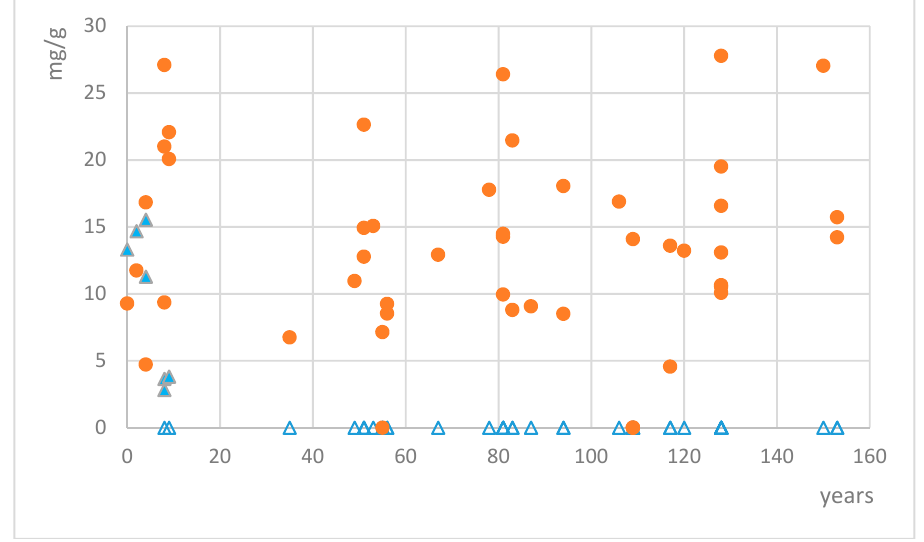
Figure 3. Concentrations of mycosporine glutamicol (red circles) and mycosporine glutaminol (blue triangles, empty triangles = no mycosporine glutaminol detected) in dried extracts of fresh and preserved European specimens of the lichen Dermatocarpon luridum var. luridum .